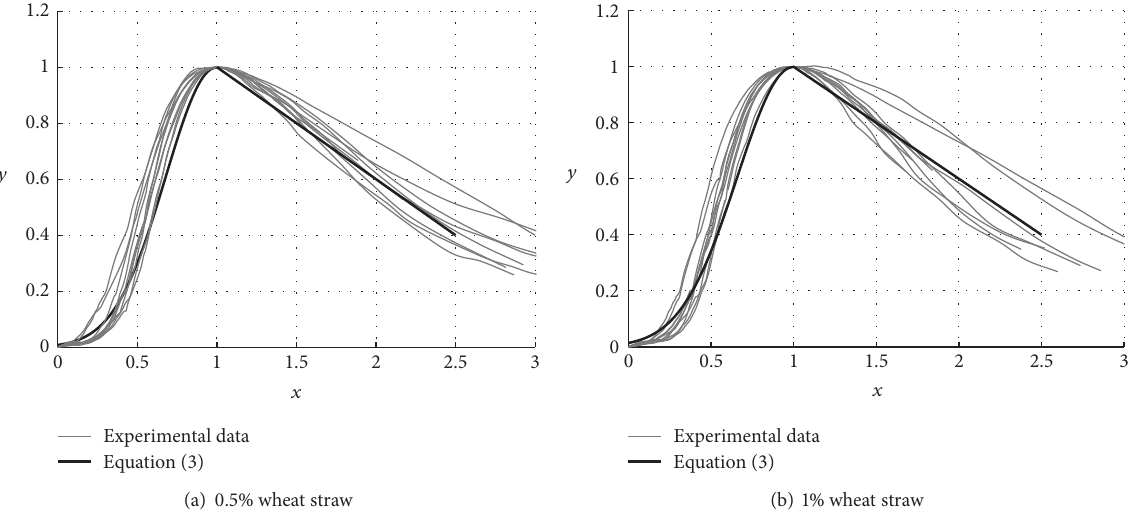
Figure 10: Dimensionless stress-strain curves of straw soil.